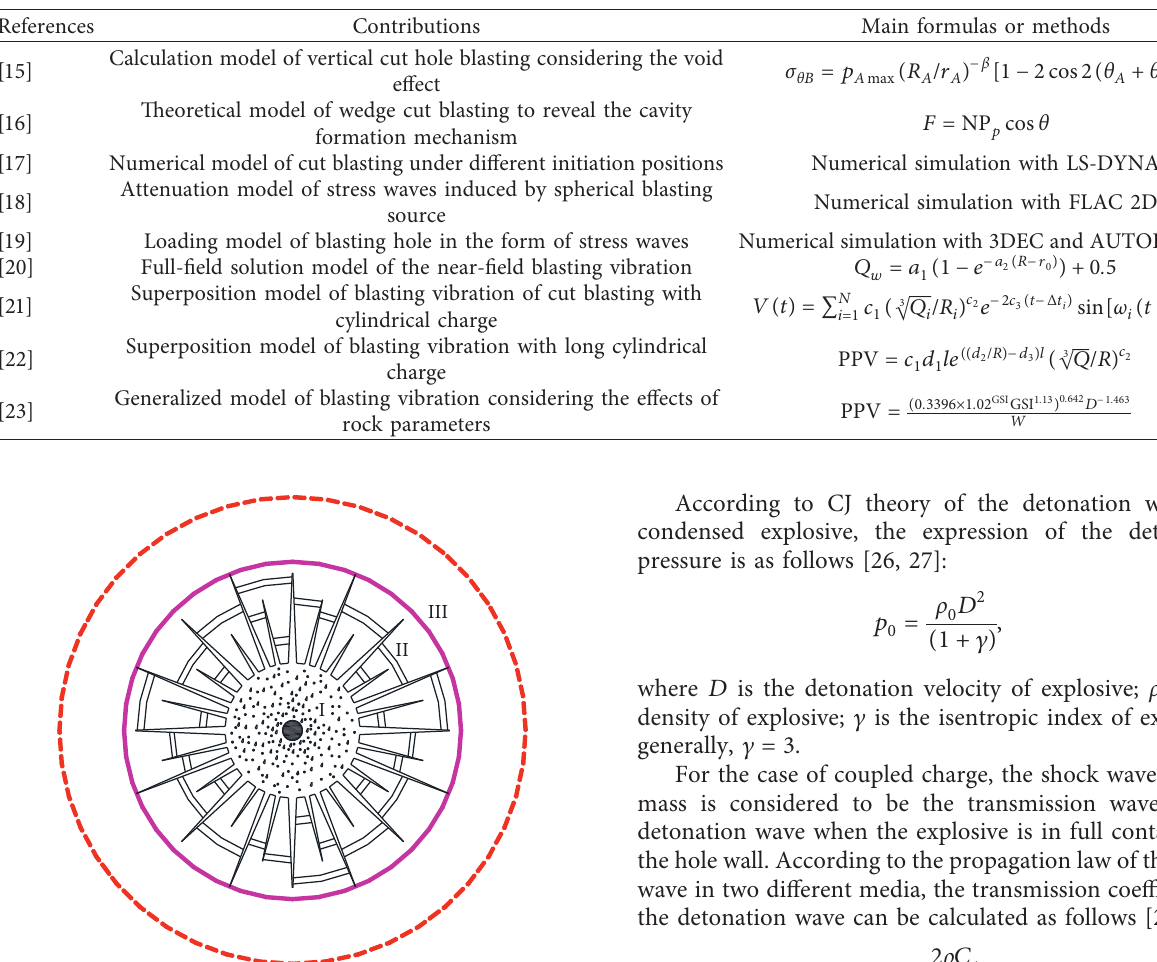
Table 1: Summary of cut blasting models or vibration models caused by cut blasting.